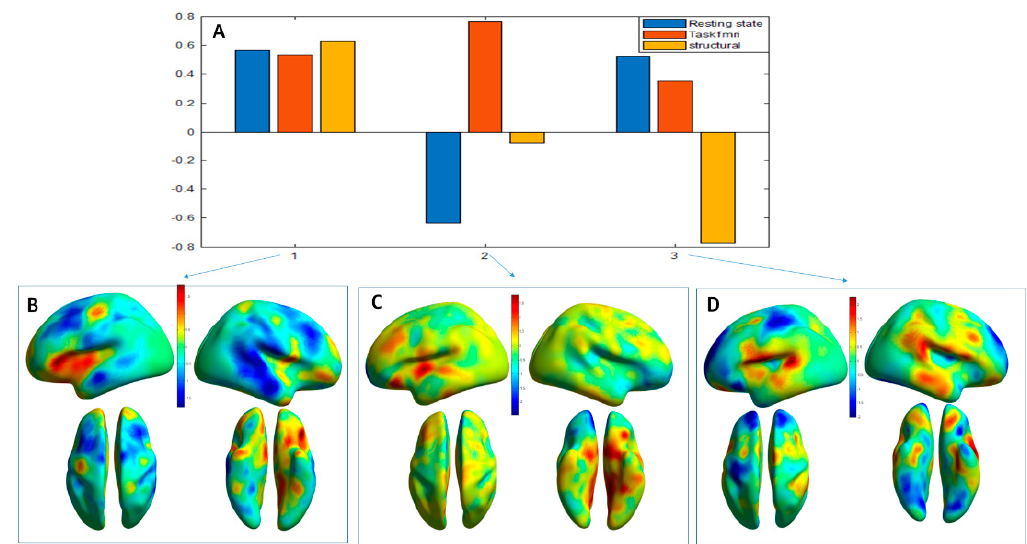
Figure 3. Second stage MLM analysis across modalities: The top figure ( A ) represents bar plots for the three components (1,2,3) with the contribution of each modality (resting state fMRI—blue, task fMRI—red, structural MRI—yellow). For the first component, the contribution is almost equal for all the modalities. The second bar plot, shows that that the second component is driven by the functional modalities. The last bar plot, shows that the largest contribution in the third com- ponent is from the anatomical brain signature. ( B–D ) are the corresponding eigen-images calculated by MLM projected on a 3D surface. The voxel values in the eigen-images represent the correlation of the value across all subjects at that voxel with the identified principal components. The eigen-images above were automatically parcellated into 114 gray matter regions based on Neuromorphometrics atlas (containing cortical and subcortical structures) using the SPM atlas function (spm_atlas in SPM12). To identify which regions were contributing the most to the combined brain signature across modalities, we calculated the average of the voxel’s projections from the maps in Figure 3A–D for all regions of the Neuromorpho- metrics atlas. The results are shown in the Figures 4 - 6 for the first, second and third com- ponent respectively.